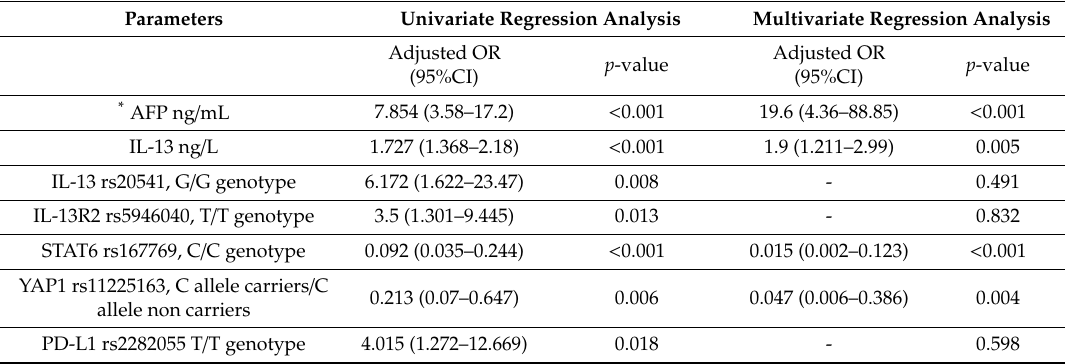
Table 3. Association between adjusted significant parameters with HCC development in